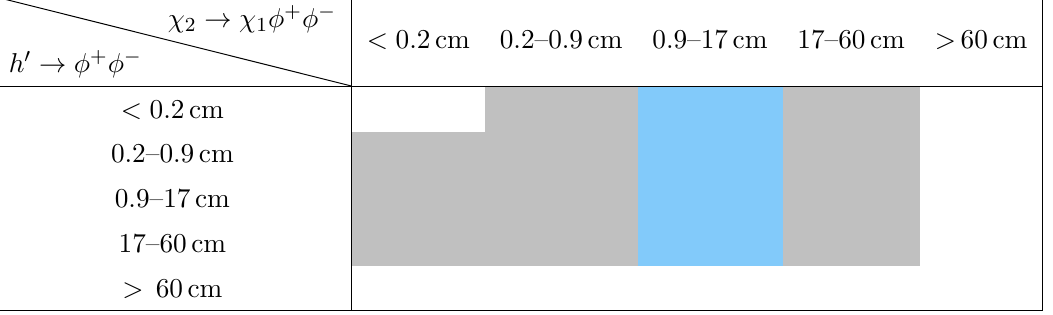
Table 2 . Decay vertex regions for different values of radial displacement for the case h 0 → φ + φ − with φ = µ, π, K used for the region selection : in the gray region all χ χ 2 → χ 1 φ + φ − with φ = e, µ, π, K while in the light blue region only χ 2 → φ + φ − with φ = µ, π, K are considered due to significant pair conversion backgrounds for electrons.